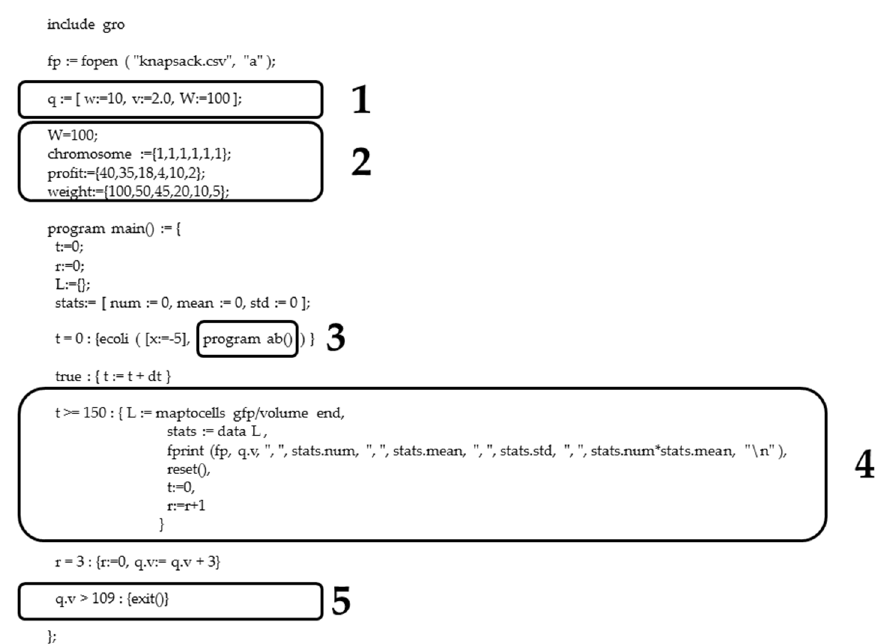
Figure A5. 0 / 1 knapsack problem implemented in Gro language. ( 1 ) Record with the three variables of the optimization problem: weight ( q.w ), value ( q.v ) and maximum capacity or weight ( q.W ) of the knapsack. Note how the weight of the knapsacks is set lower ( q.v = 10) than the maximum tolerated weight ( q.W = 100), with the initial value of the knapsacks being set in two units ( q.v = 2.0). ( 2 ) Knapsack instance. ( 3 ) Call for the screening routine, in this case, selection is conducted with antibiotics. ( 4 ) Save the evaluation or fitness in a file “ knapsack.csv ”. ( 5 ) The termination condition is met when the knapsack includes all items reaching the maximum value, but does not satisfy the weight restriction. In the output of the routine in Gro, i.e., the points ( x 1 , y 1 ), ( x 2 , y 2 ), ... , ( x n , y n ), the value of x is the value of the knapsack ( q.v ), whereas y, i.e., the total amount of GFP or fitness value, is calculated as stats.num*stats.mean .